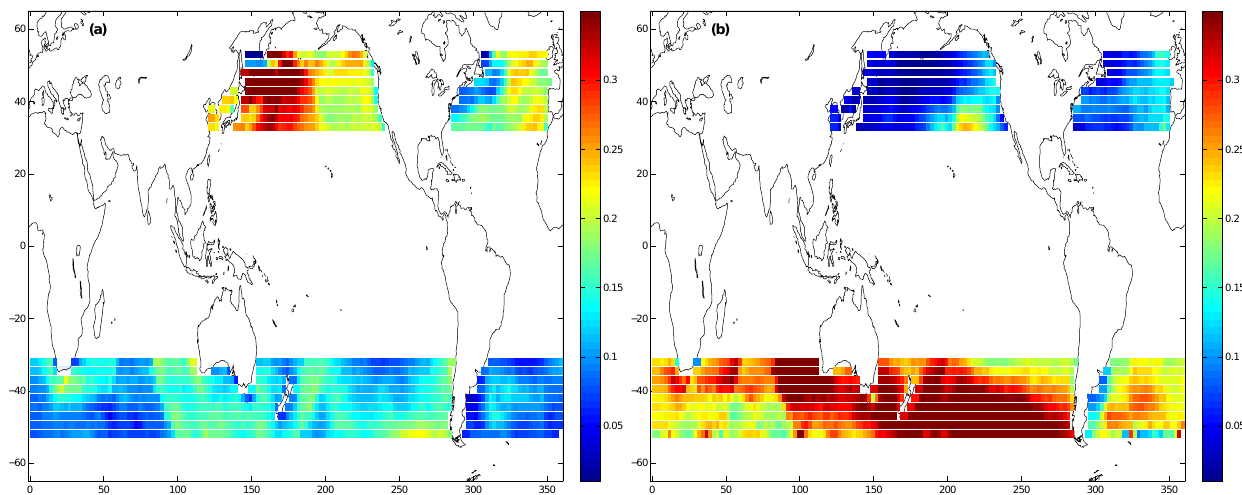
Fig. 9. Seasonal mean climatological spatial distributions of the frequency of Cluster 2 (Large Cumulus), (a) DJF and (b) JJA.